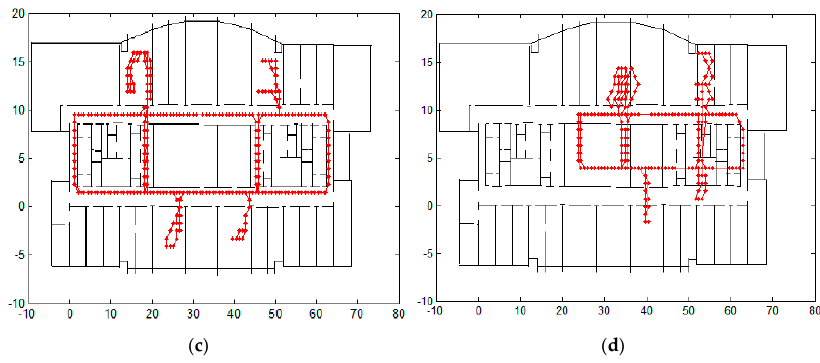
Figure 6. Comparison of trajectory: ( a ) raw trajectory; ( b ) trajectory using CRFs without feedback; ( c ) trajectory using proposed method; and ( d ) trajectory using step length as observations.